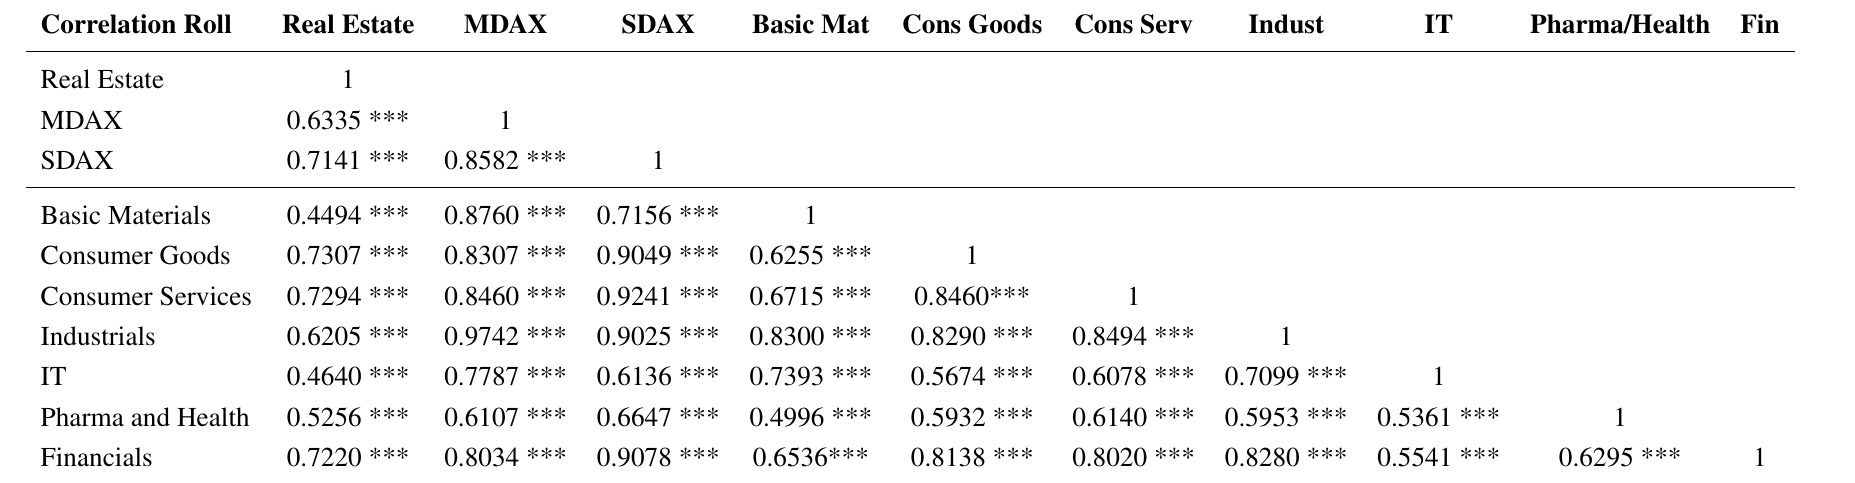
Table A2. Roll measure correlations between several asset